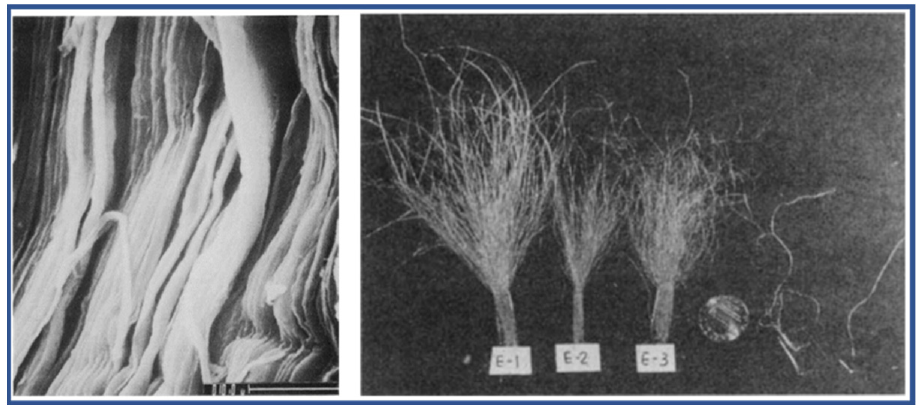
Figure 5. Growth-packed micron-sized PPTA fibers [40]. Copyright 1987 Springer